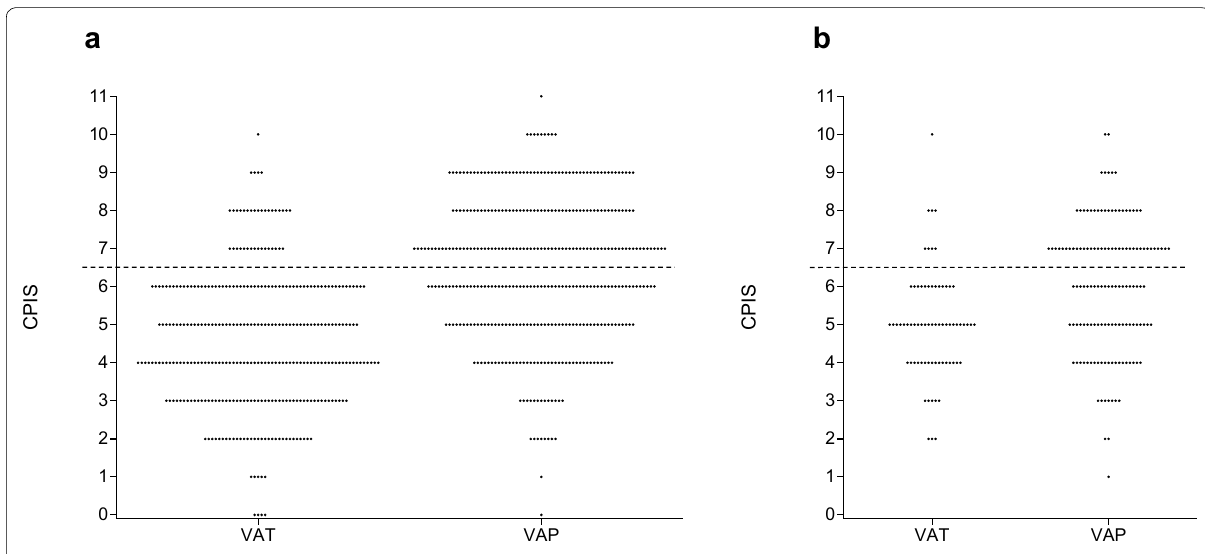
Fig. 3 Scatter dot plots of CPIS in patients with VAT and VAP in the derivation ( a ) and validation ( b ) cohorts relatively to the 7‑point cut‑off. The CPIS value is depicted as a single dot for each patient. Dash lines separate patients with a CPIS value pulmonary infection score, VAP Ventilator‑associated pneumonia, VAT Ventilator‑associated